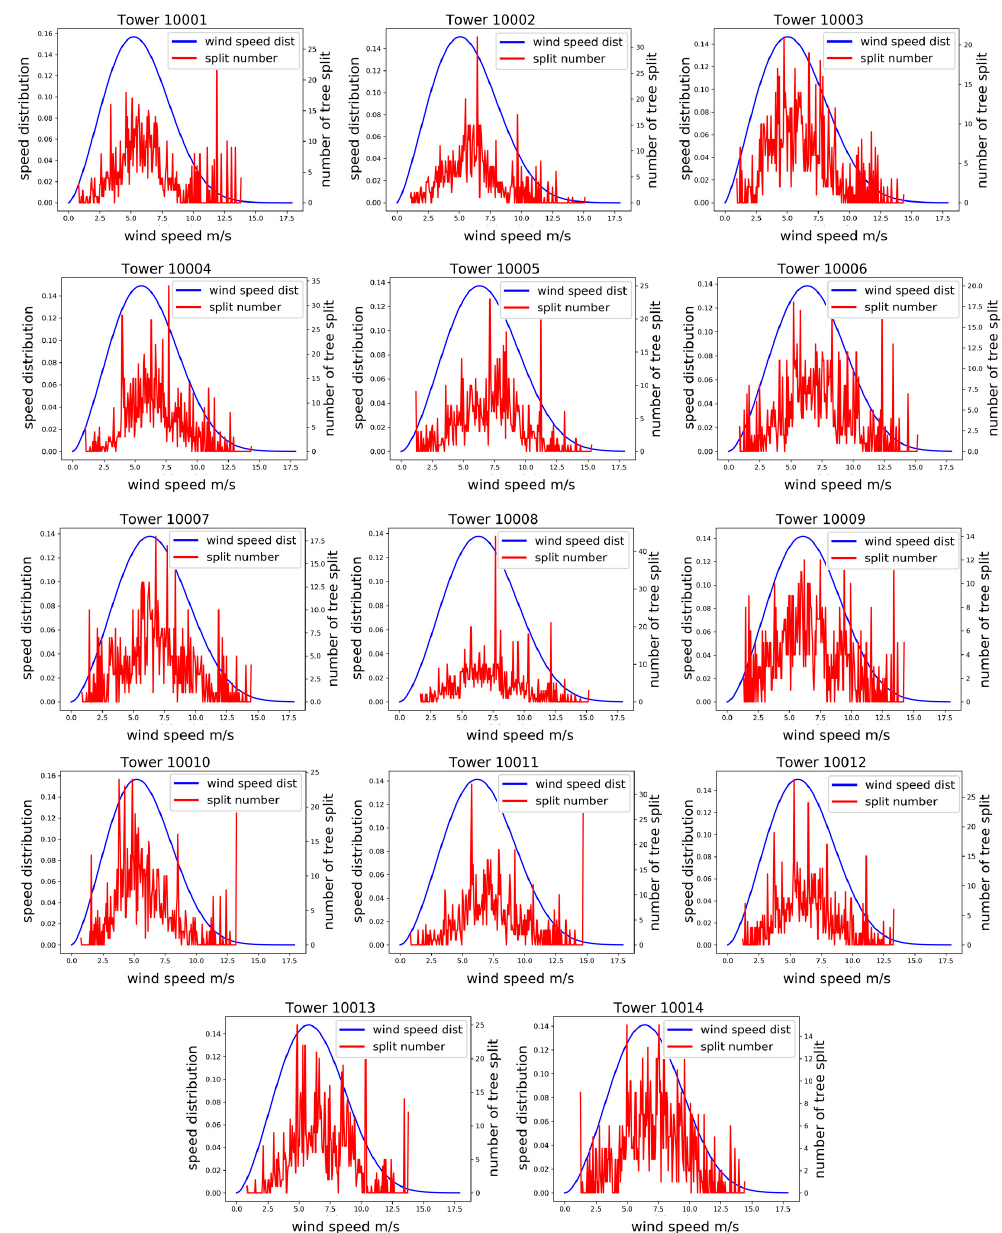
Figure 18. Distribution of 10 m speed feature split values and Weibull distribution of 10 m wind speed observation of all 14 towers.